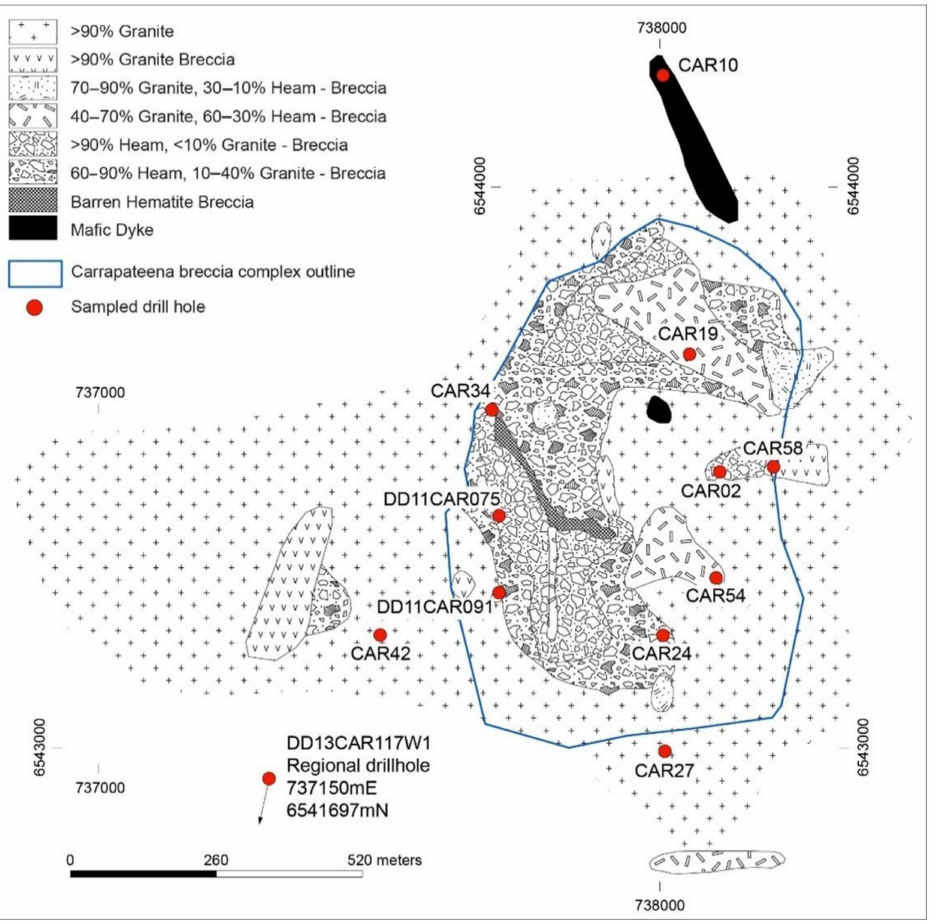
Figure 3. Top of basement geological map of the Carrapateena deposit showing the location of sampled drill holes. Location of the Carrapateena deposit is shown in Figure 1. Modified from